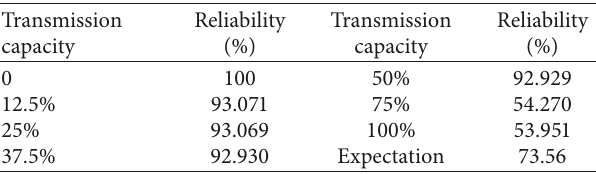
Table 5: Reliability of different transmission capacity of a